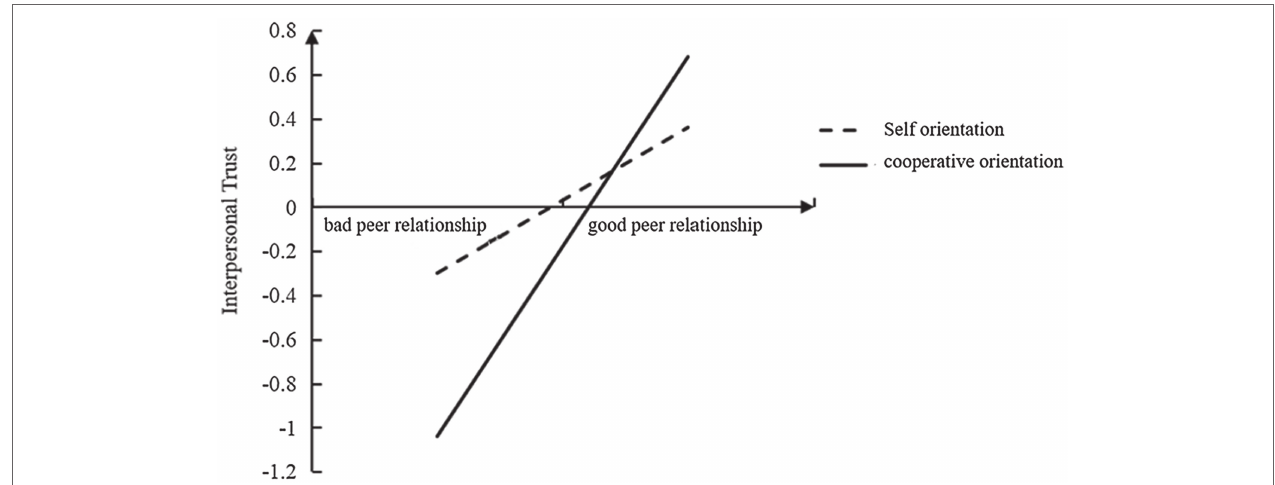
FIGURE 2 | The moderating role of social value orientation in peer relationships affecting interpersonal